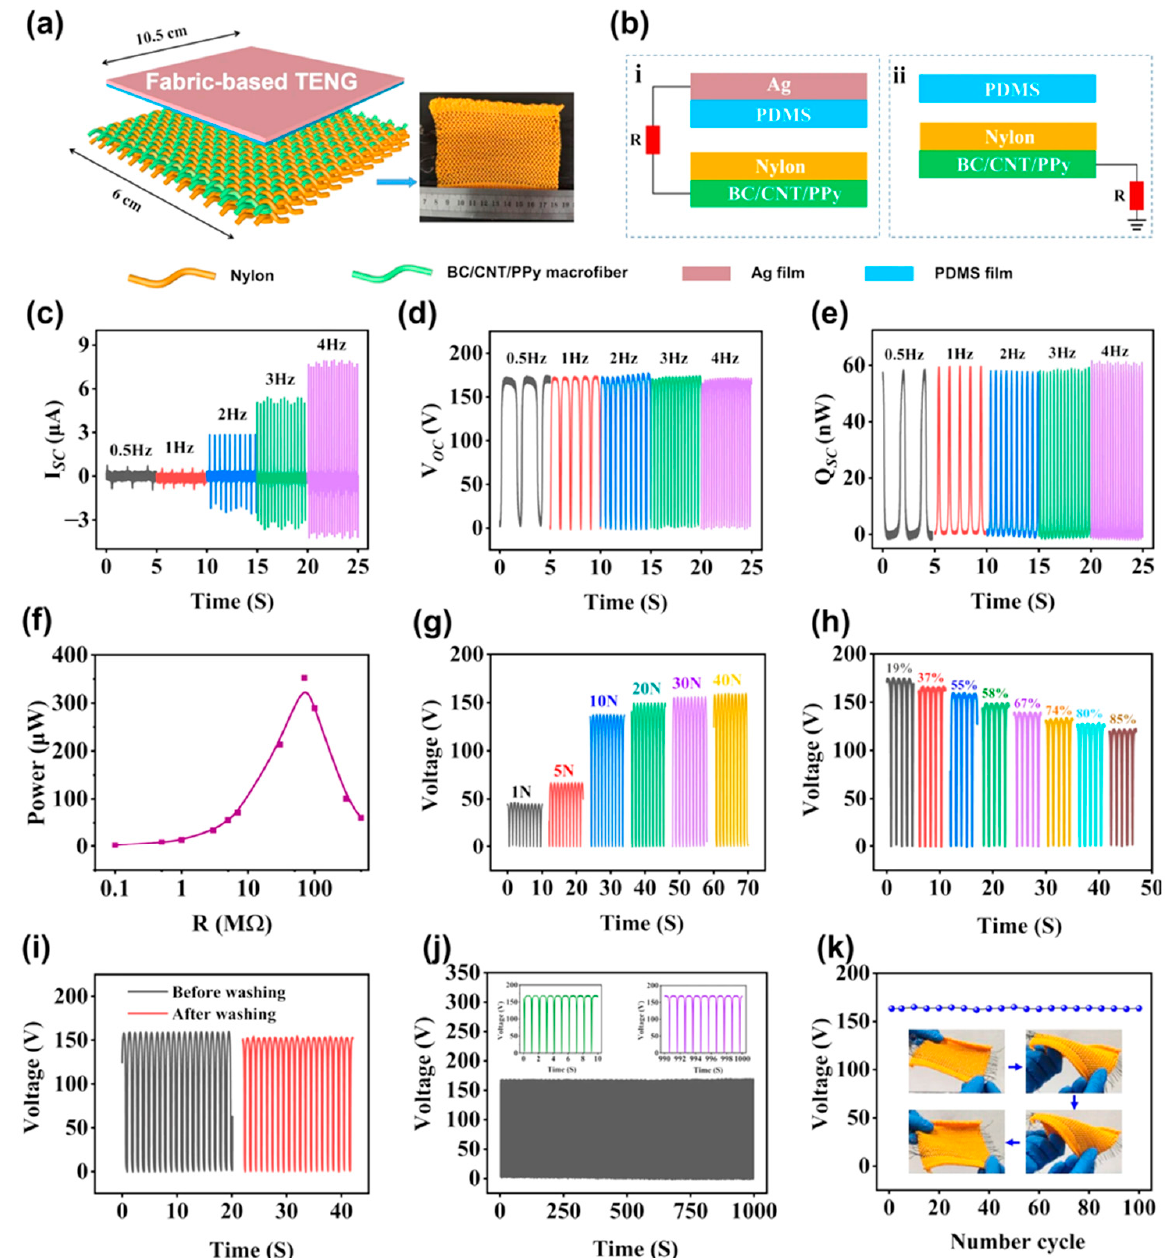
Figure 5. ( a ) Schematic view of the main components and materials of the fabric-based TENG designed by Hu et al. [155]; ( b ) two operating modes of the fabric-based TENG, ( i ) contact-separation mode and ( ii ) single electrode mode. Response of the ( c ) short-circuit current, ( d ) open-circuit voltage, and ( e ) transferred charges of the fabric-based TENG under different frequencies. ( f ) Results of